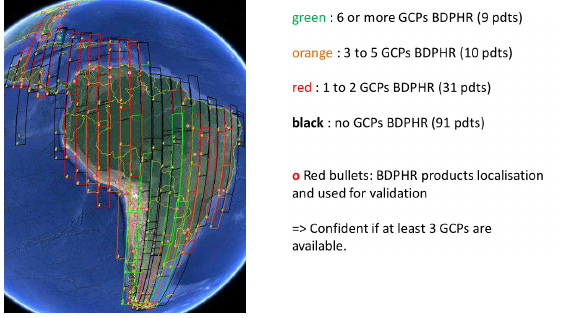
Figure 16. BDPHR number per South America GRI products.